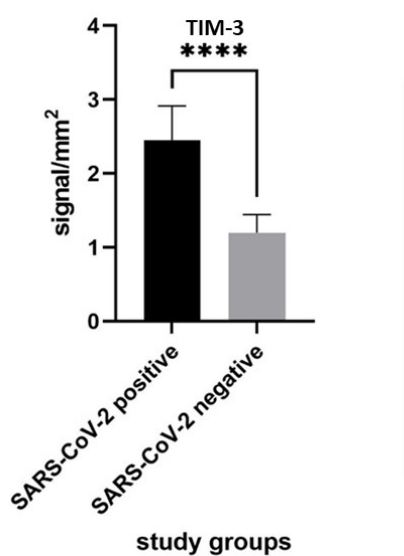
Figure 7. Different levels of immunoexpression also for TIM-3 in the two populations: note that, with the same lymphocyte population (CD4 and CD8 not statistically different), the lymphocytes present in the study arm of SARS-CoV-2 positive patients were immunolabeled for TIM-3 more than in the second group ( p value: <0.0001). **** statistic significative.